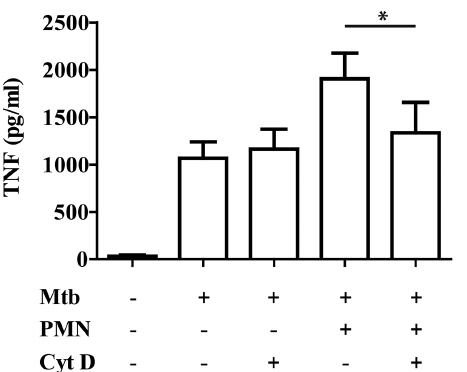
Figure 3. Apoptotic neutrophils enhance the hMDM capacity to control intracellular Mtb. hMDMs were infected with Mtb H37Rv and uptake was determined (D0). Following infection, hMDMs were stimulated with PMNapo or Jurkatapo at a ratio of 2:1. Measurements of Mtb by luminometry were performed at indicated time points. Data are presented as ratio compared to the initial bacterial load at D0 ( i.e. increase in bacterial load) and the graphs show the mean + SEM (n=5). Differences between groups are shown as * (p , 0.05), ** (p , 0.01) or *** (p , 0.001).